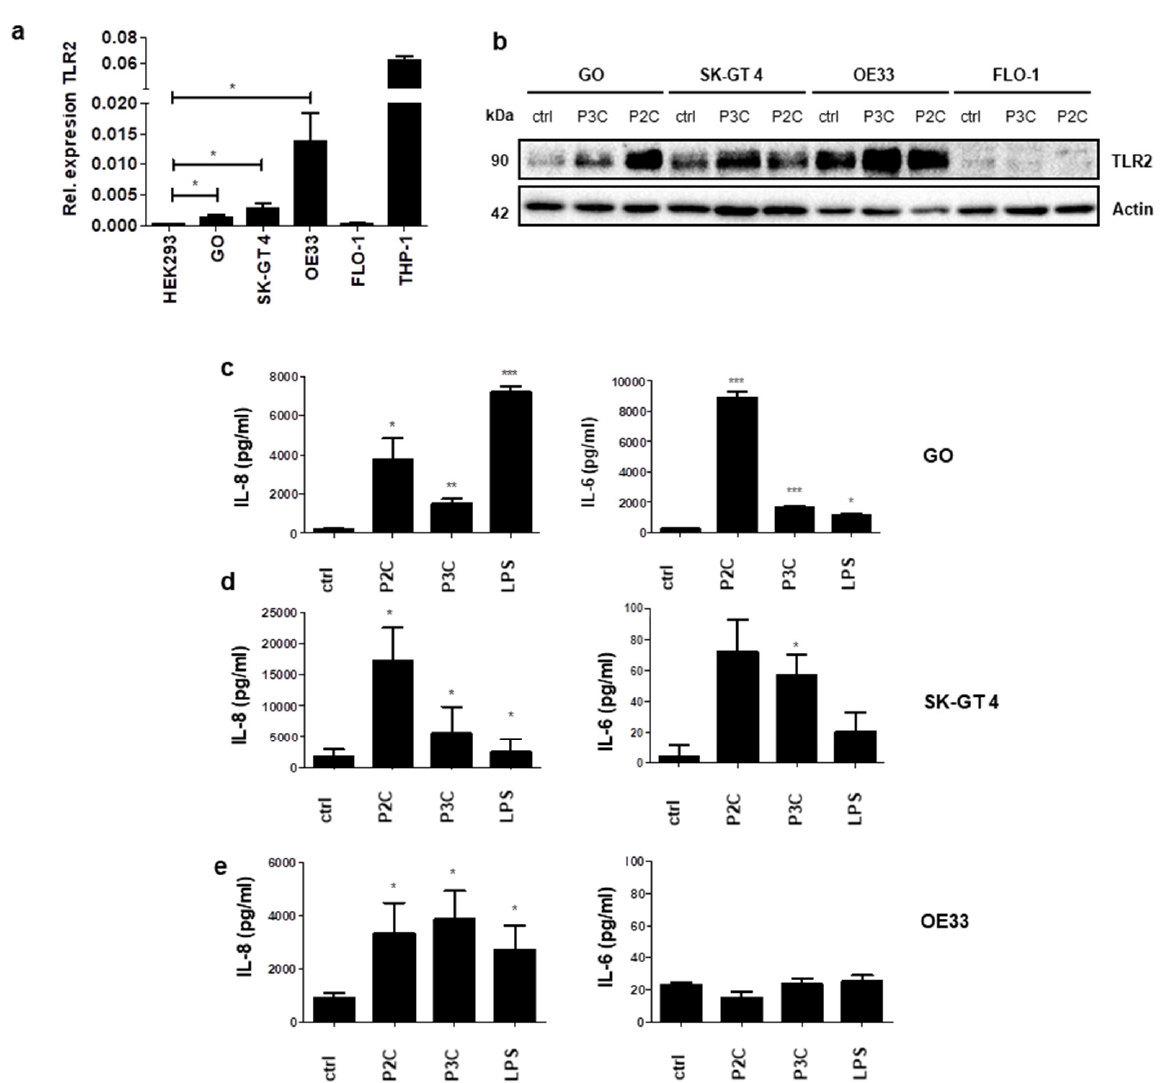
Figure 1. Characterising TLR2 expression and response to TLR2 ligands in a panel of oesophageal cell lines. ( a ) TLR2 mRNA levels were determined in oesophageal cell lines GO, SK-GT 4, OE33 and FLO-1. HEK293 (human embryonic kidney) and THP-1 (human monocytic) cells were included as negative and positive controls, respectively. Data represent mean ± SEM of n = 3; * p < 0.05 (unpaired two-tailed Student’s t -test). ( b ) Oesophageal cell lines were left unstimulated (ctrl), stimulated with Pam3CSK4 (P3C, 0.05 µ g/mL) or Pam2CSK4 (P2C, 0.05 µ g/mL) for 24 h before analysis of lysates for TLR2 expression by Western blot. Blot is representative of three independent experiments. Oesophageal cell lines: ( c ) GO; ( d ) SK-GT 4; and ( e ) OE33; were stimulated for 24 h with: P3C (0.05 µ g/mL), P2C (0.05 µ g/mL) or LPS (1 µ g/mL). IL-6 and IL-8 secretion levels were determined by ELISA. Data shown are representative of three independent experiments. Unpaired two-tailed Student’s t -test to compare the mean ± SEM values between treated and untreated cells; * p < 0.05; ** p < 0.01; *** p <